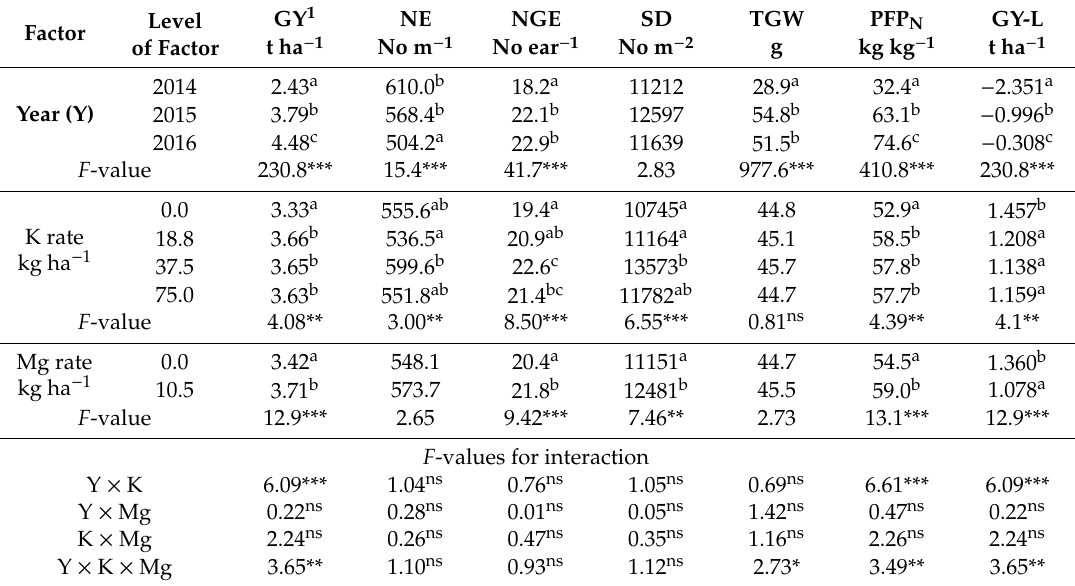
Table 2. Grain yields of spelt wheat and yield